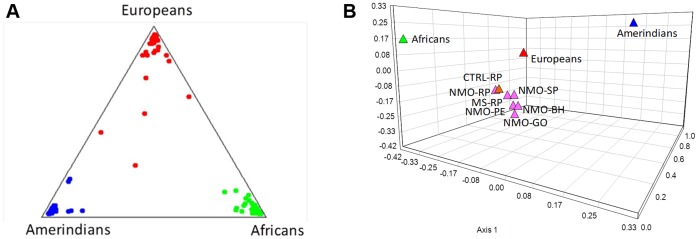
Information of ancestry informative markers (AIMs) set for ancestral populations, multiple sclerosis (MS) and neuromyelitis optica (NMO) patients.(A) The panel of 12 ancestry informative markers (AIMs) for Africans (green), Europeans (red) and Amerindians (blue) were sufficient for an adequate discrimination among ancestral populations. (B) Principal components analysis (PCA) for NMO [Southeastern: Ribeirão Preto (NMO-RP), São Paulo (NMO-SP) and Belo Horizonte (NMO-BH); Central:-Goiânia (NMO-GO), and Northeastern: (Recife-Pernambuco (NMO-PE)] and MS patients from Ribeirão Preto (MS-RP) and control individuals from Ribeirão Preto (CTRL-RP) together with ancestral populations [Africans (green), Europeans (red) and Amerindians (blue)], showing that they clustered closer to Europeans than to Africans and Amerindians.